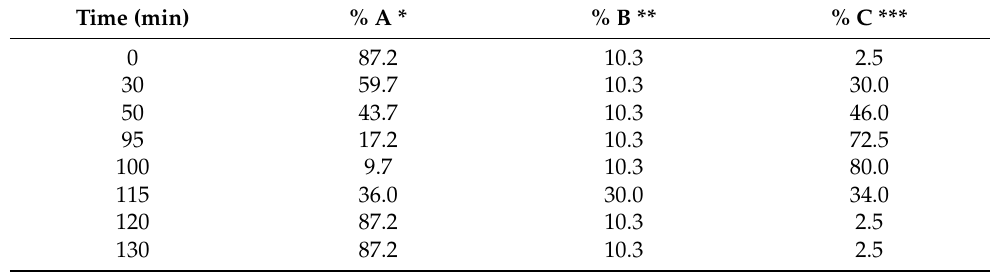
Table A1. The gradient used in CarboPac PA200 column for qualitative analysis of FOS/GOS. Time (min)